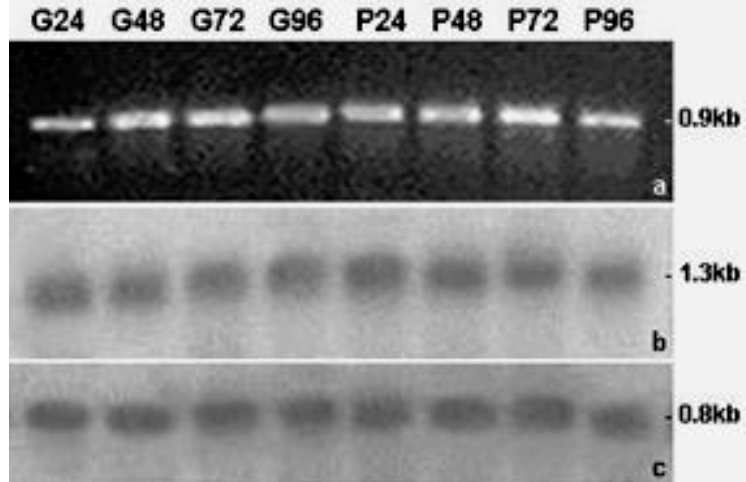
Figure 4. Dhpg expression on pectin induced mycelium. Samples: glucose (g) cultures at 24 h, 48 h,72 h, 96 h; pectin (P) cultures at 24 h, 48 h,72 h, 96 h. a. RT-PCR on RNAs with RTEPF-RTEPR primers, annealing T 63°C. b-c. Northern hybridi - zation on cDNAs with coding Dhpg as a specific probe in b (PCR product with EPF-EPR, annealing T 65°C) and atp6 as a